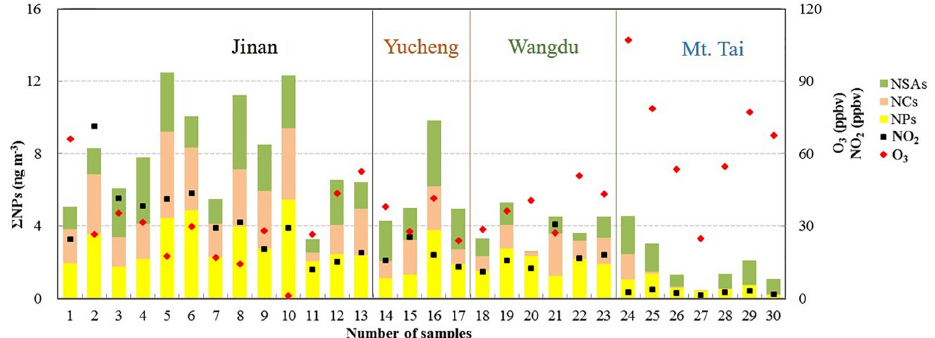
Figure 7. Time series of concentrations of three kinds of nitrated phenols in the nocturnal samples collected in the summertime and the corresponding mixing ratios of NO 2 and O 3 .